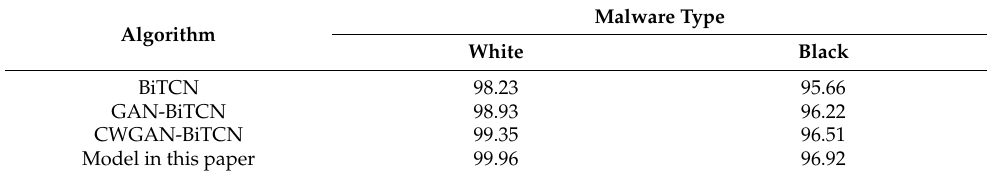
Table 8. Accuracy of different GANs on DataCon Dataset.